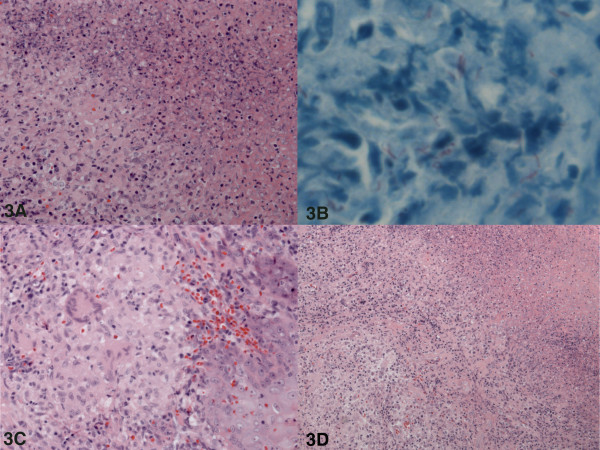
Biopsy histology. (A) Necrotising granulomatous inflammation: granuloma on the left and necrosis on the right side of the image. (B) Red stained Mycobacterium tuberculosis in Ziehl-Neelsen acid fast stain. (C) Granuloma with a multinucleated giant cell in the center (left side of image). (D) Overview of a necrotising granulomatous inflammation: granulomas on the left side and necrosis on the right.